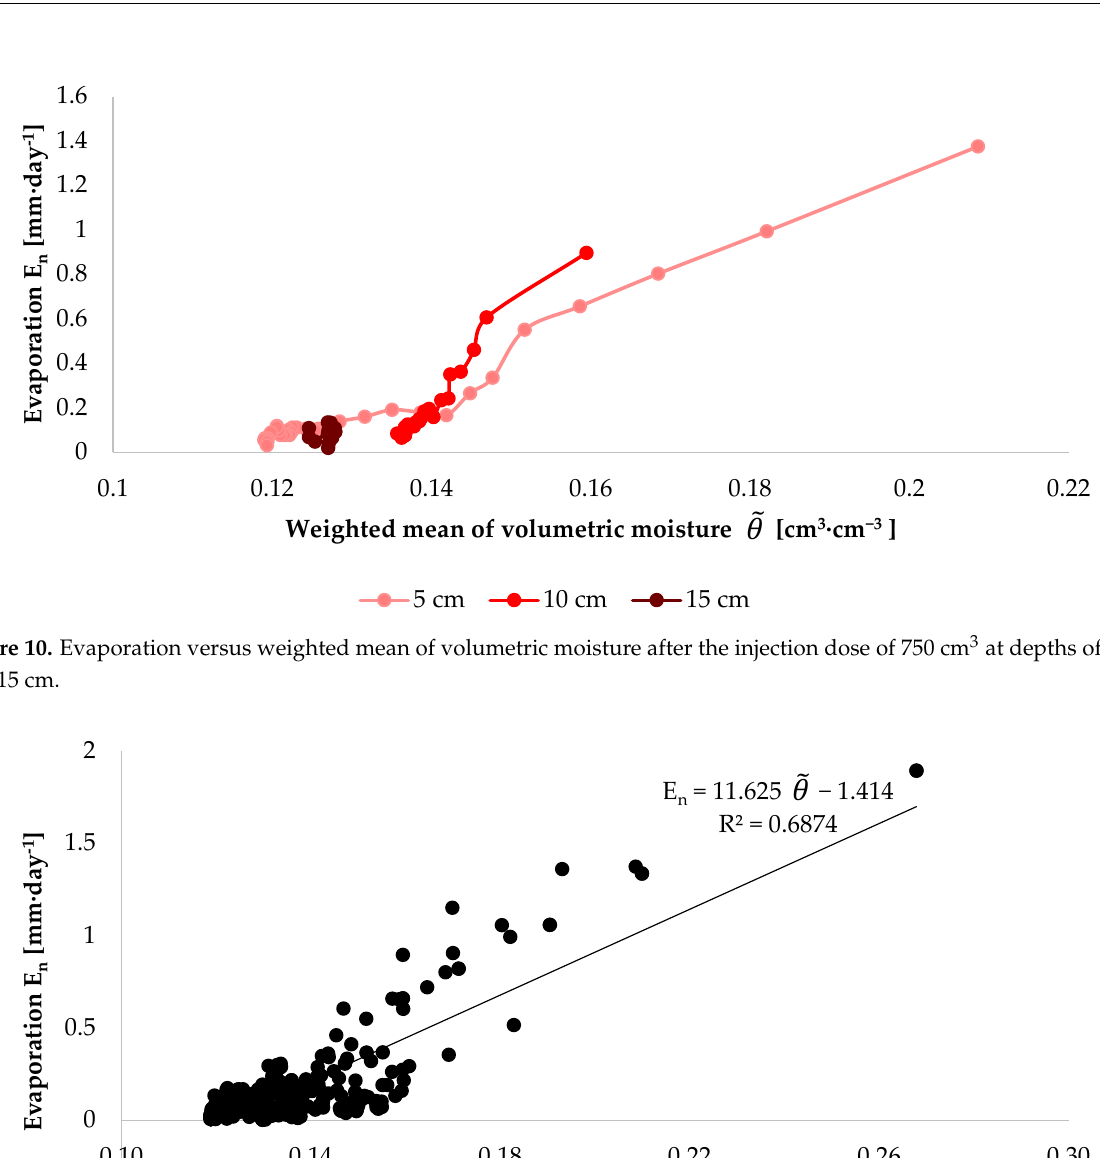
Figure 9. Evaporation versus weighted mean of volumetric moisture of soil after the injection of 250, 450, 750 and 1000 cm 3 of water at the depth of 10 cm.